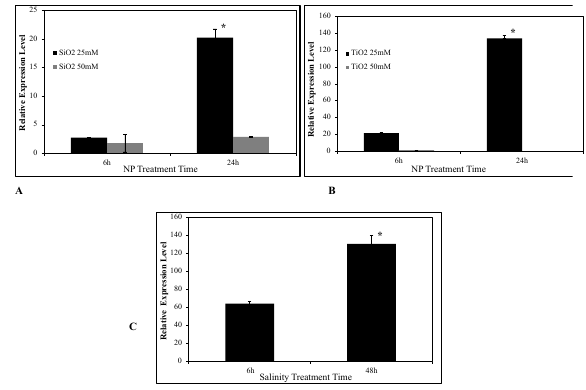
Fig. 4. The effect of elicitors on expression of COST gene in fever- few: A) SiO 2 NP treatment; B) TiO 2 NP treatment; C) salinity